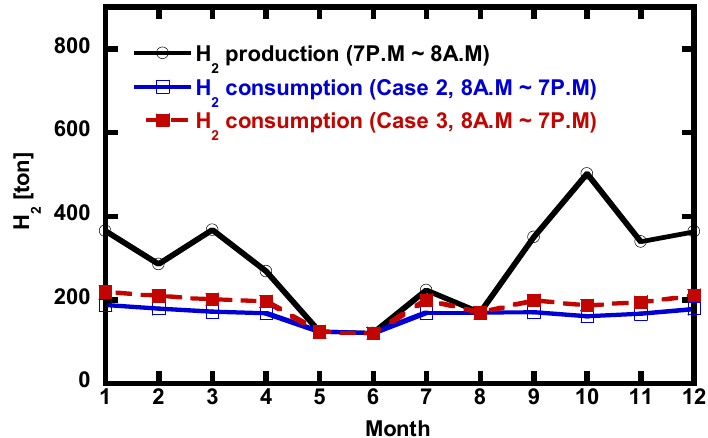
Figure 10. Annual hydrogen production and consumption.